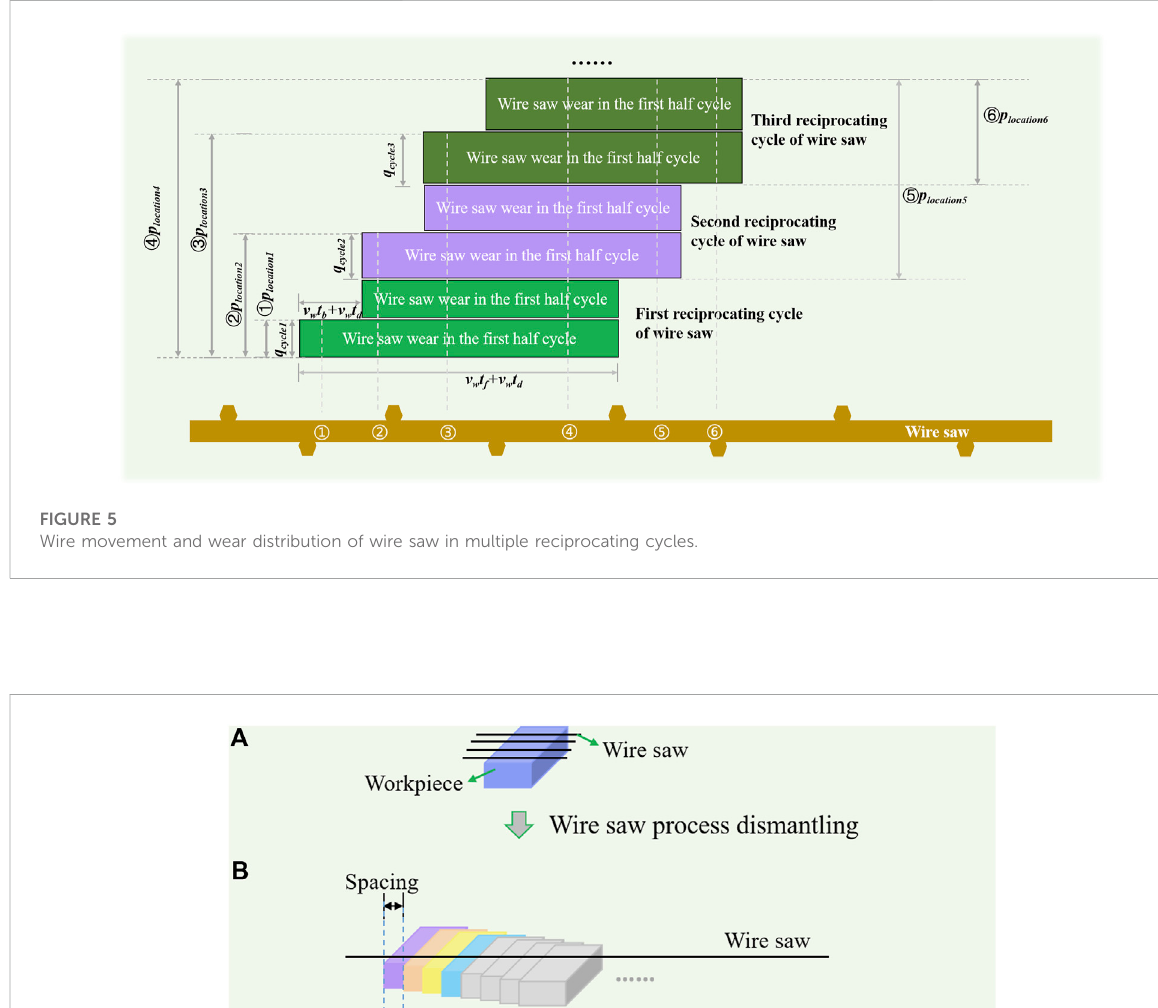
Frontiers in Mechanical